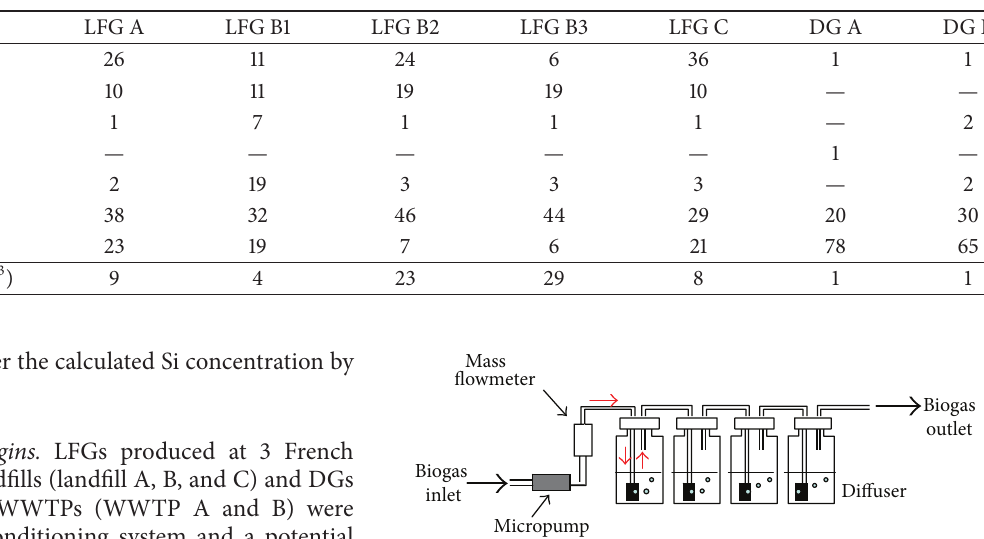
the decrease of analyte volatilization outside of the mist drops and a reduction of the induced overestimation. Si concentrations are determined at 251.6 nm with a viewing height above load coil of 5 mm and a radial plasma viewing mode. The torch was vertical, demountable with a 3 mm i.d. injector. The radiofrequency power used was of 1400 W, the sample uptake was of 0.5 mL/min, the nebulisation pressure was of 1 bar, and plasma gas flow rate and sheath gas flow rate were, respectively, of 16 and 0.35